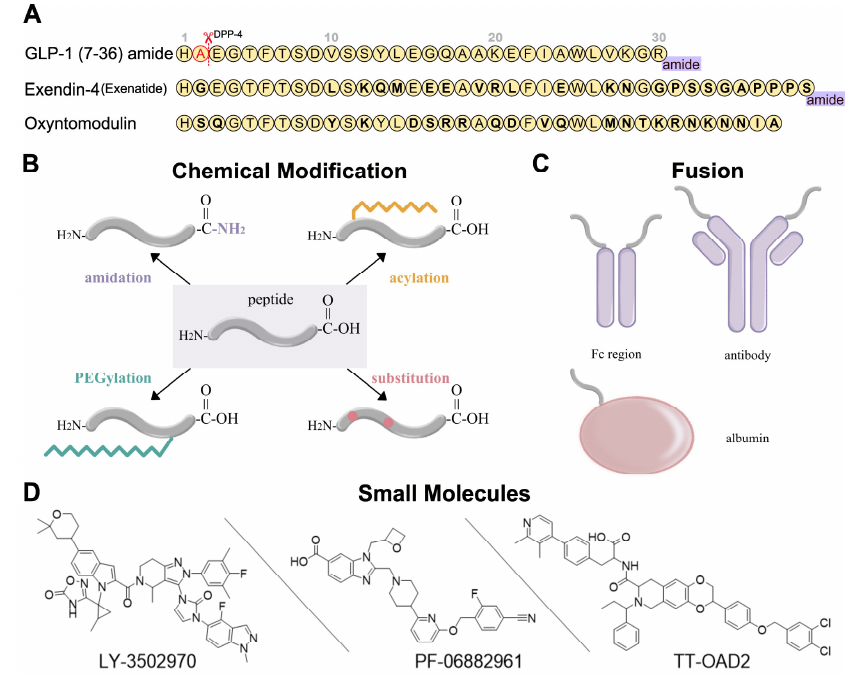
Figure 2. Development strategies for GLP-1R ligands [16,52,53] . (A) Amino acid sequences of GLP- 1 (7-36) amide, exendin-4, and oxyntomodulin. Different residues from GLP-1 are in bold type.